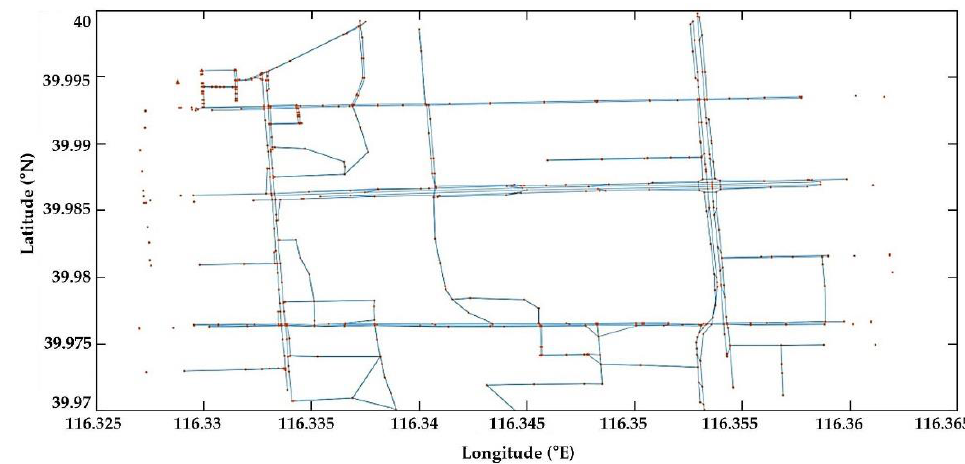
Figure 4. The regional transportation network under study shown in MATLAB. The specific data include detector information, roadway information, and speed information with the following specific feature